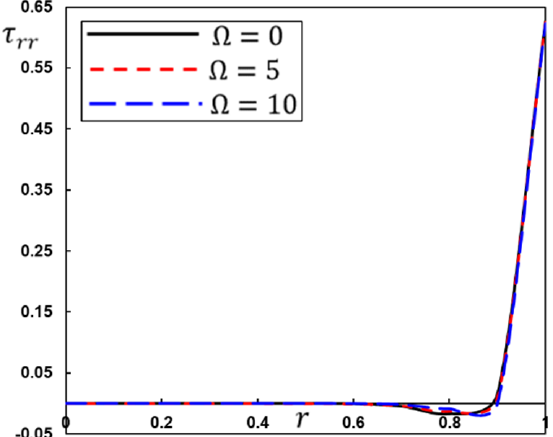
Figure 12. Maxwell’s stress τ rr for different rotation parameter Ω .